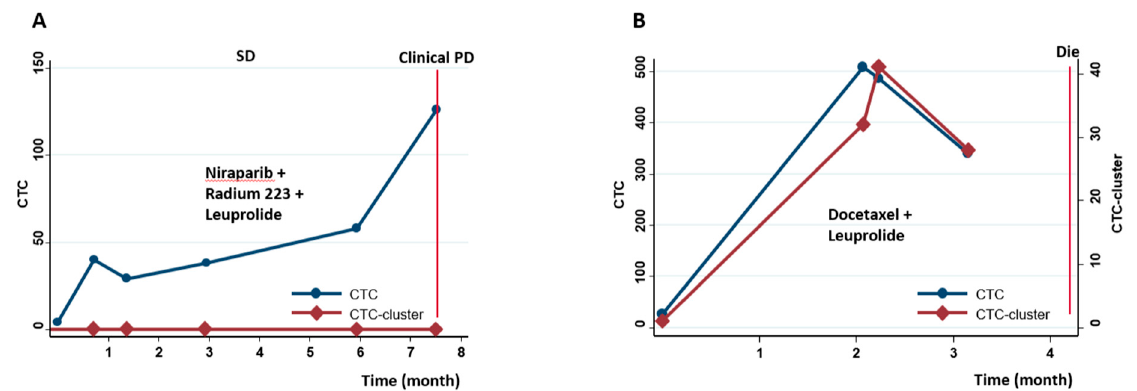
Figure 3. Longitudinal monitoring of CTCs and CTC-clusters in individual patients. ( A ) A patient had high CTC counts but without any CTC-cluster; ( B ) A patient had both high CTC counts and CTC-clusters.